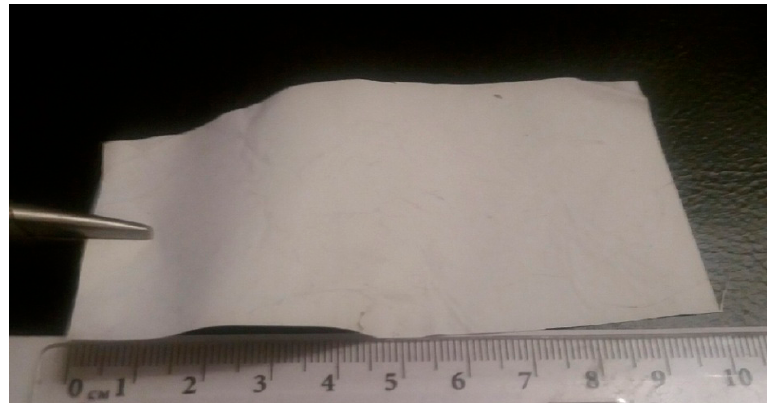
Figure 1. Picture of processed material.